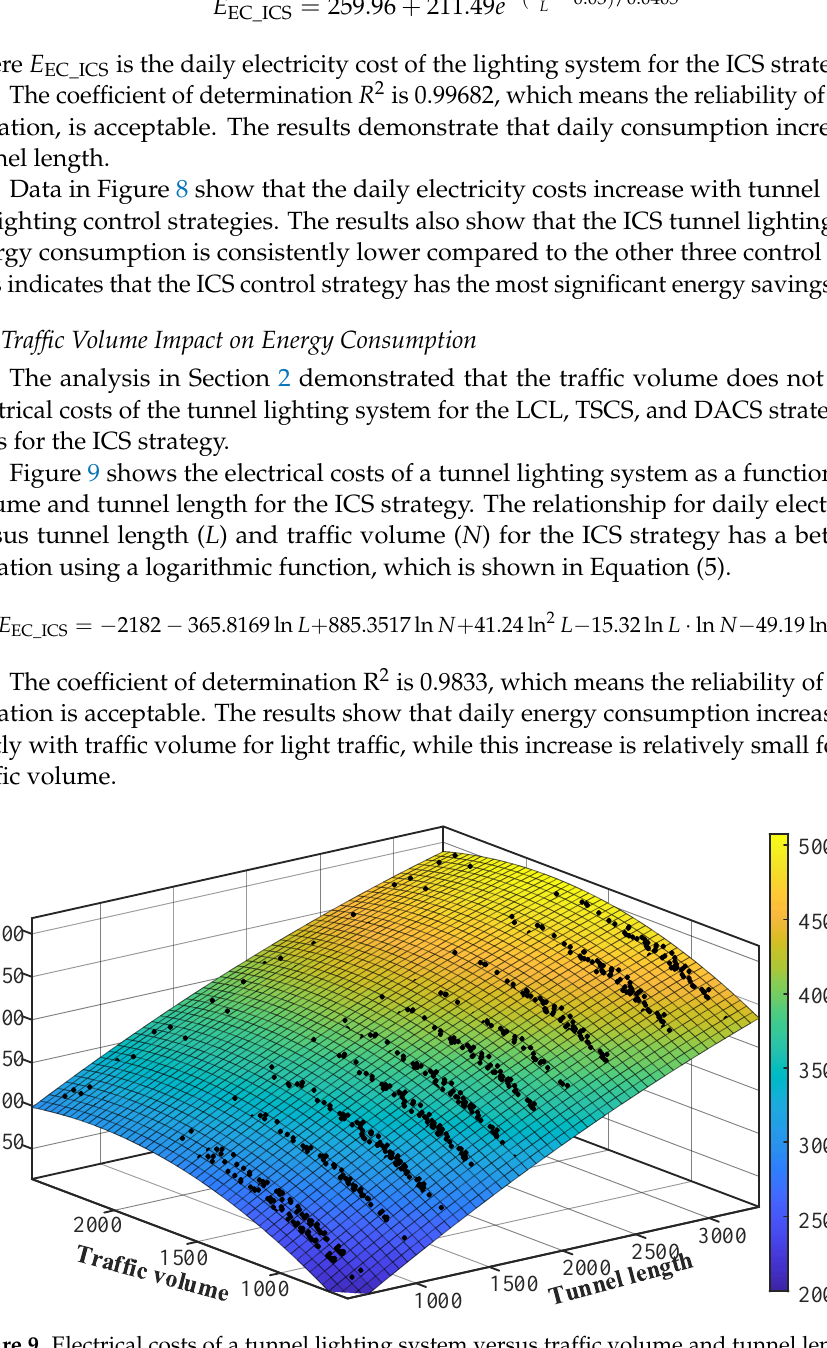
Figure 9. Electrical costs of a tunnel lighting system versus traffic volume and tunnel length for the ICS strategy.